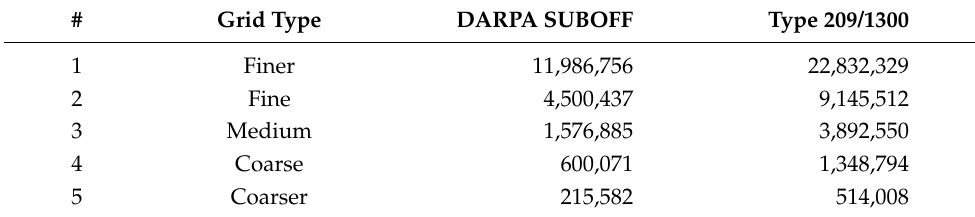
Table 4. Number of cells for uncertainty analysis.